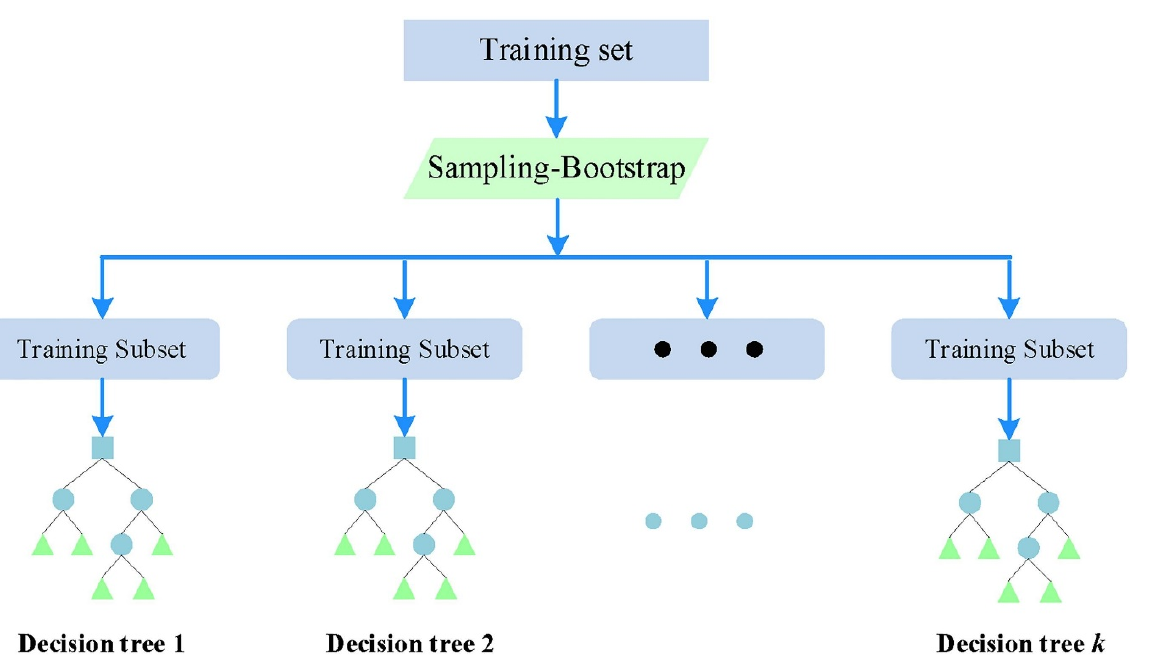
Figure 8. Schematic diagram representation of the random forest formation process [99] .